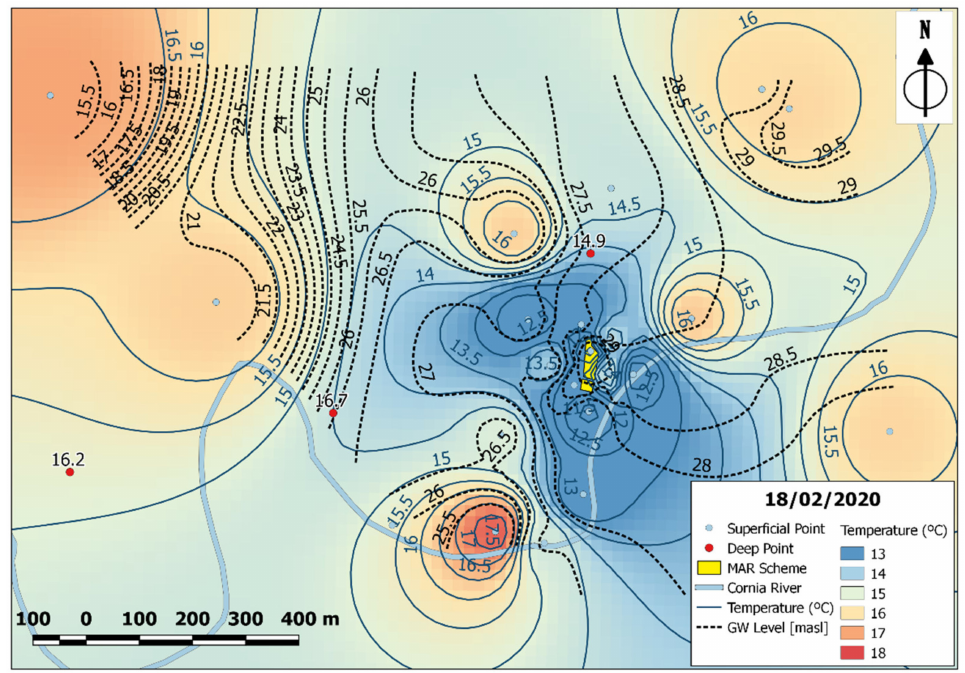
Figure 9. Groundwater temperature distribution after 7 days of the restart of MAR operations.